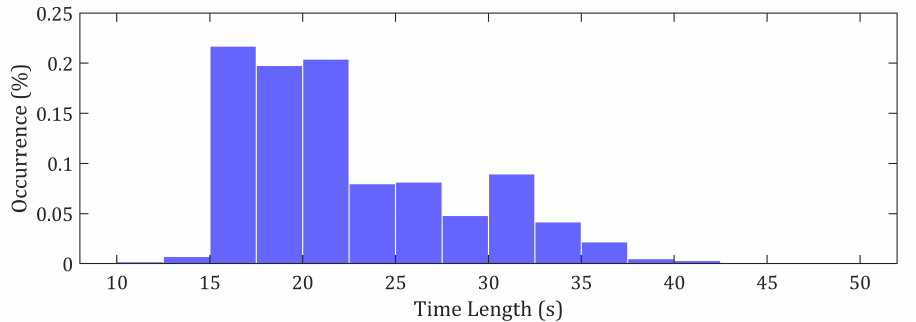
Figure 5. Length of the evaluated occultation segments. The average plateau length is around